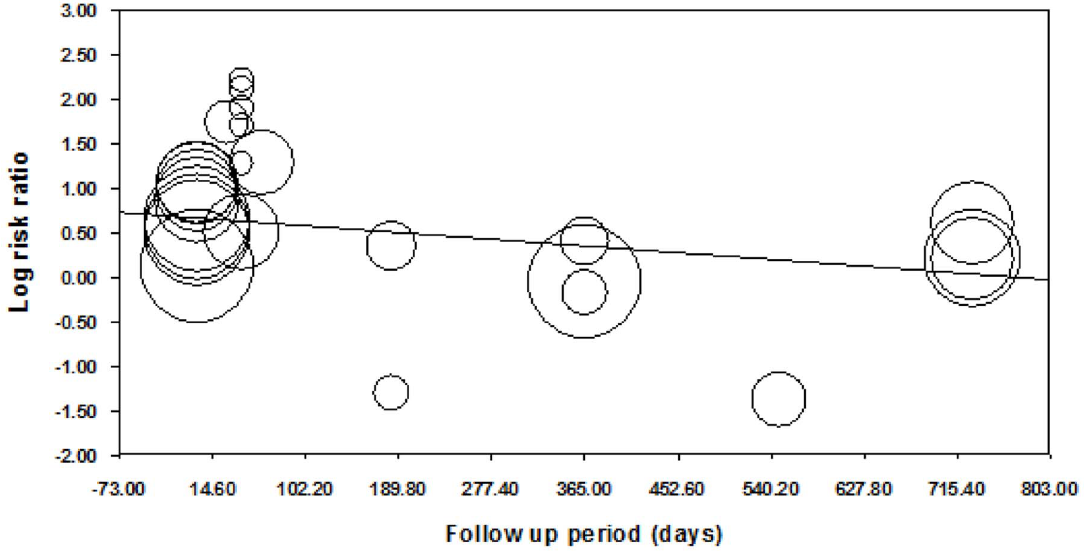
Figure 15. Meta-regression of follow-up point on relative risk, all behaviours (latest follow-up point).